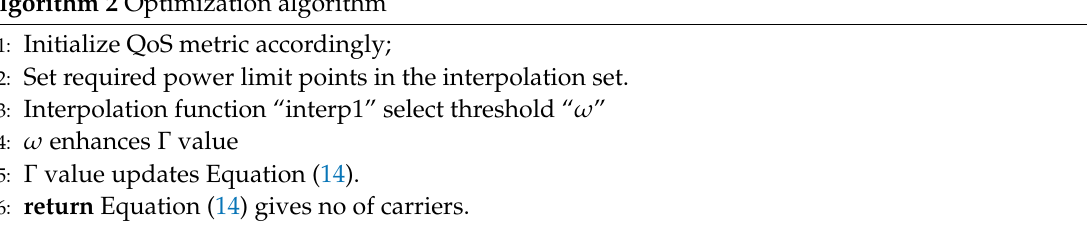
Algorithm 2 Optimization